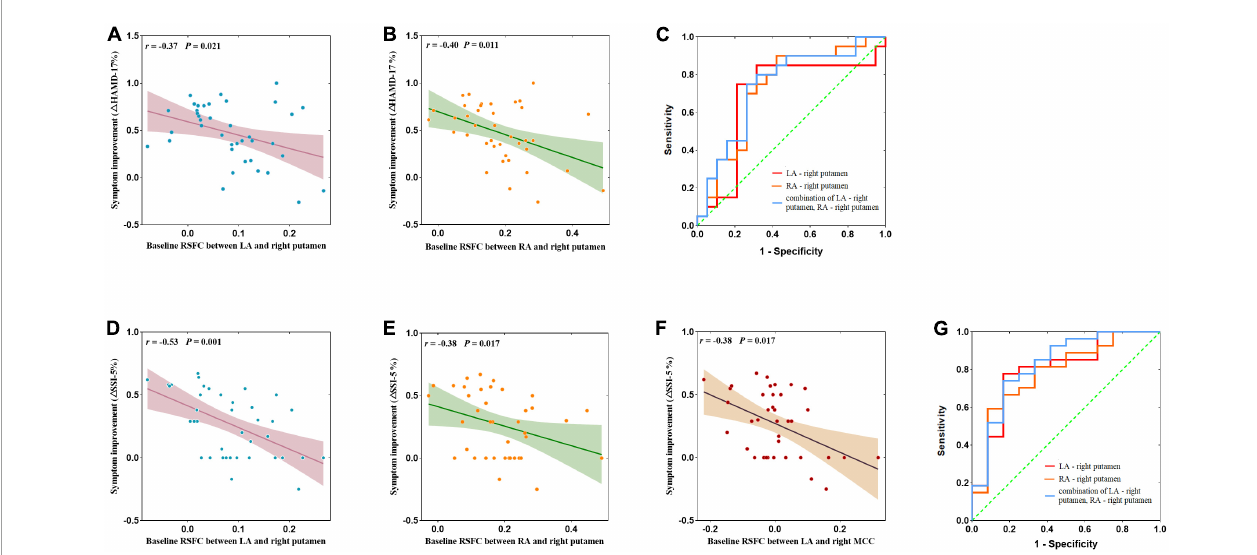
FIGURE4 (A,B,D–F) Correlation between abnormal amygdala RSFC at baseline and the remission rate of depressive symptoms and suicidal symptoms after ketamine treatment and ROC curve analysis. (C) Neuroimaging predictors of treatment non-response, with the non-responders defined with < 50% improvements in HAMD-17 obtained after the ketamine infusions. The area under the ROC curve was 0.689 ( p = 0.043) for the RSFC of the LA – right putamen, with a sensitivity of 91.4%, and specificity of 59.1%; the area under the ROC curve was 0.726 ( p = 0.016) for RA – right putamen connectivity, with a sensitivity of 82.4%, and specificity of 68.2%; and the area under the ROC curve was 0.739 ( p = 0.011) for LA – right putamen connectivity and RA-right putamen connectivity, with a sensitivity of 75.0%, and specificity of 73.7%. (G) Non-responders defined with < 50% improvements SSI-5 score obtained after the ketamine infusions. The area under the ROC curve was 0.799 ( p = 0.003) for the RSFC of the LA – right putamen, with a sensitivity of 77.8%, and specificity of 83.3%; the area under the ROC curve was 0.787 ( p = 0.005) for the RA – right putamen connectivity, with a sensitivity of 59.3%, and specificity of 91.7%; and the area under the ROC curve was 0.827 ( p = 0.001) for LA – right putamen connectivity and RA – right putamen connectivity, with a sensitivity of 74.1%, and specificity of 83.3%. AUC, area under curve; LA, left amygdala; RA, right amygdala.